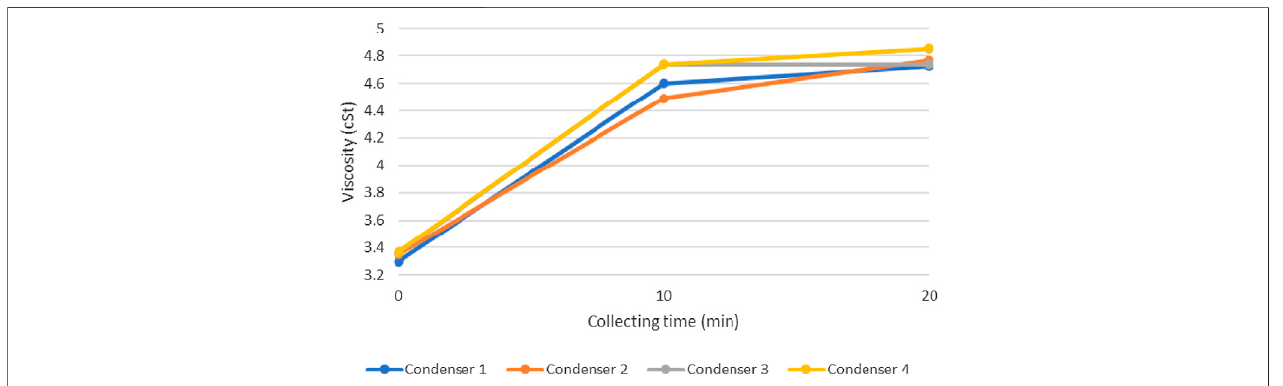
FIGURE 12 | Viscosities of products from each condenser at different collecting time (pyrolysis temperature (cid:1) 450 ° C).